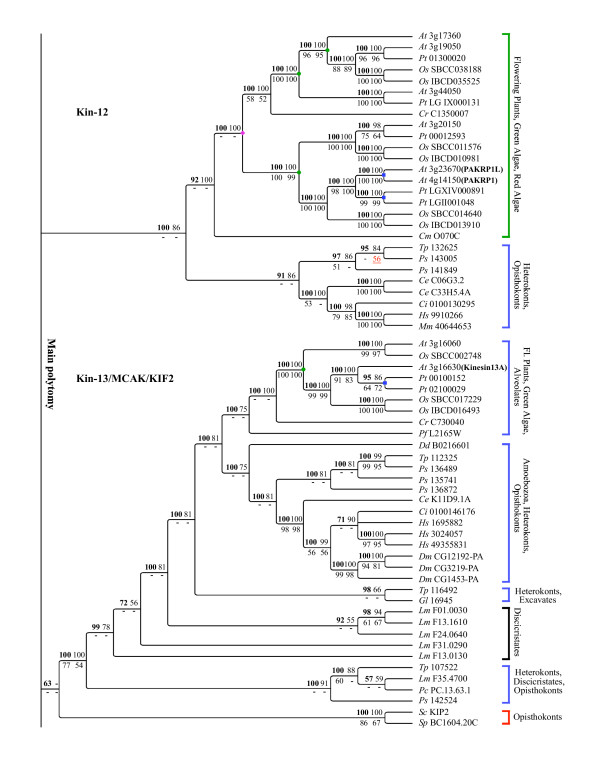
Expanded view of Kinesin-12 and Kinesin-13 families. Expansion of the Kinesin-12 and Kinesin-13 families from Fig. 2. Experimentally studied Arabidopsis kinesins are indicated in parenthesis with their published names in bold. Green brackets indicate plant specific groups, mixed clades are shown in blue brackets, black brackets indicate protozoan species and red brackets indicate groupings composed of opisthokonts. Purple diamond indicates a gene duplication after the divergence of red and green algae from one another yet prior to the divergence of green algae from flowering plants. Green circles and blue squares indicate gene duplications in flowering plants and dicots, respectively. See Fig. 2 legend for an explanation of support values. Support values in italicized blue font indicate those clades supported in the parsimony analyses except for the exclusion of Pt 00151235 (see text). For full names of species see Fig. 1 legend. Fl. Plants, flowering plants.